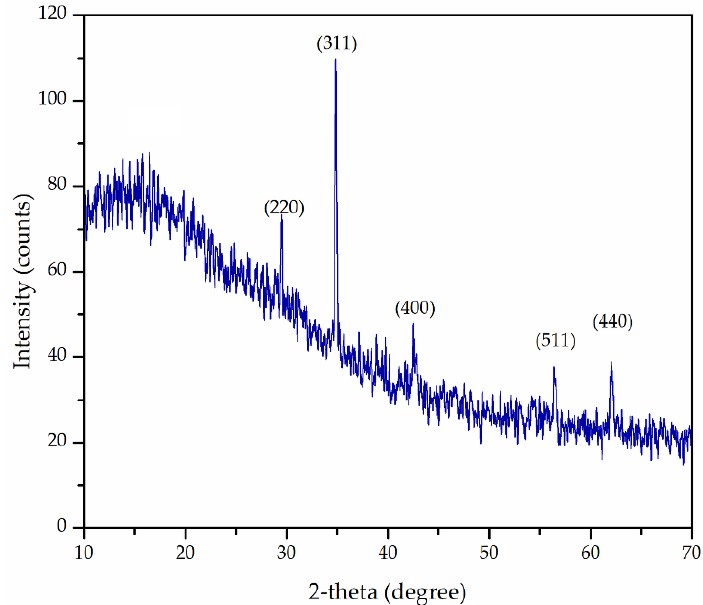
Figure 3. XRD pattern of Fe 3 O 4 @APTMS/PGME-deta.